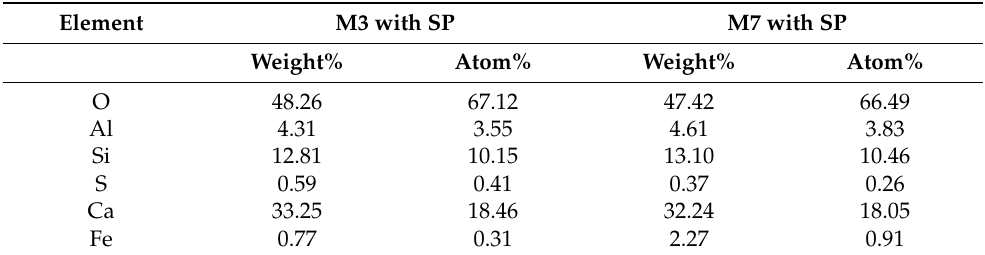
Table 4. The element compositions for the setting time samples of blended mixes M3 and M7 with